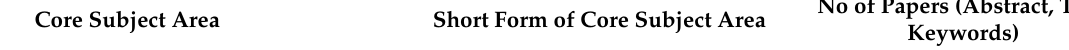
Table 4. Subject area wise